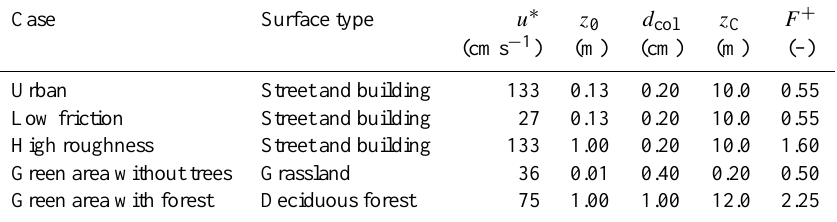
Table 2. Dry deposition of particles to urban surfaces. Parameter values used in the modelling of the reference case (all campaigns) and in the sensitivity cases for the dry deposition process. Notation: u ∗ = friction velocity, z 0 = roughness height, d col = effective collector size, z C = canopy height, F + = effective roughness length. Values for F + were adopted from Hussein et al. (2012) for corresponding surface and vegetation